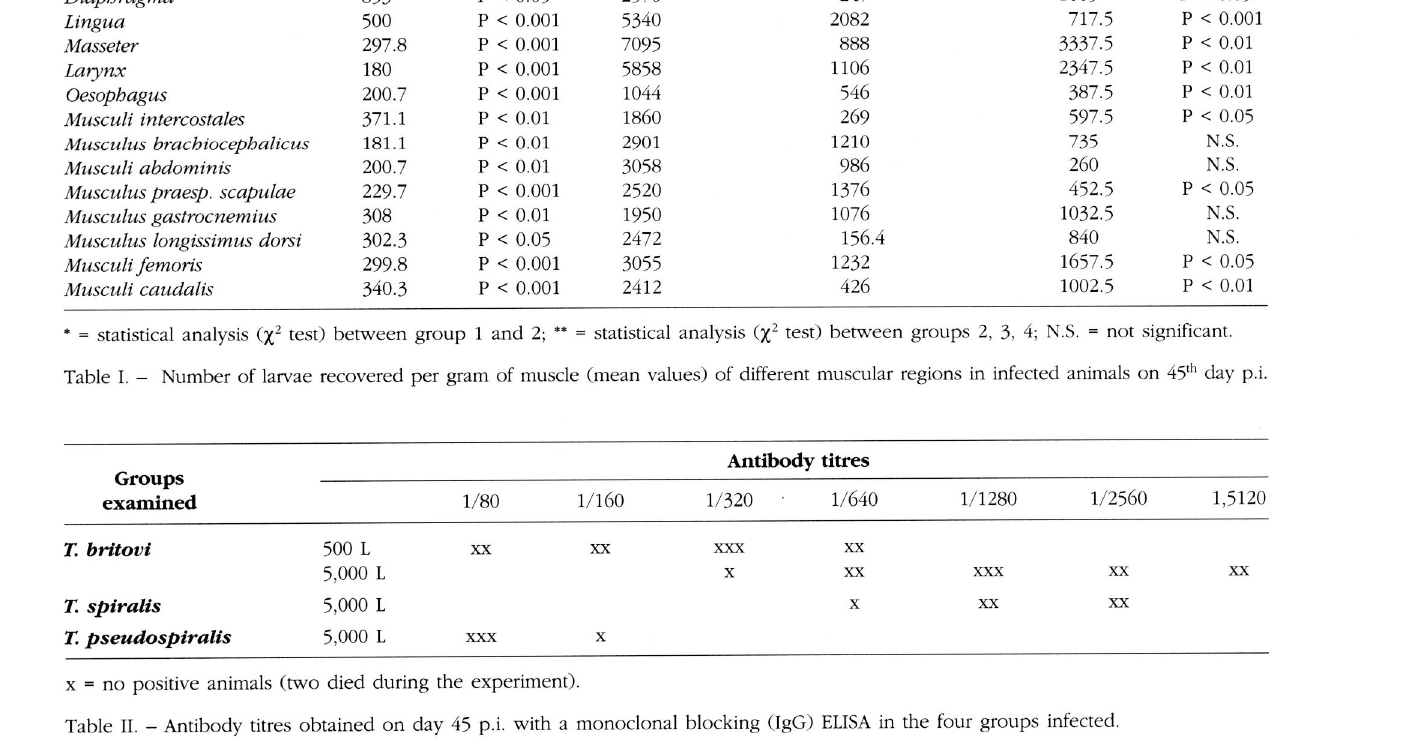
Table II. - Antibody titres obtained on day 45 p.i. with a monoclonal blocking (IgG) ELISA in the four groups